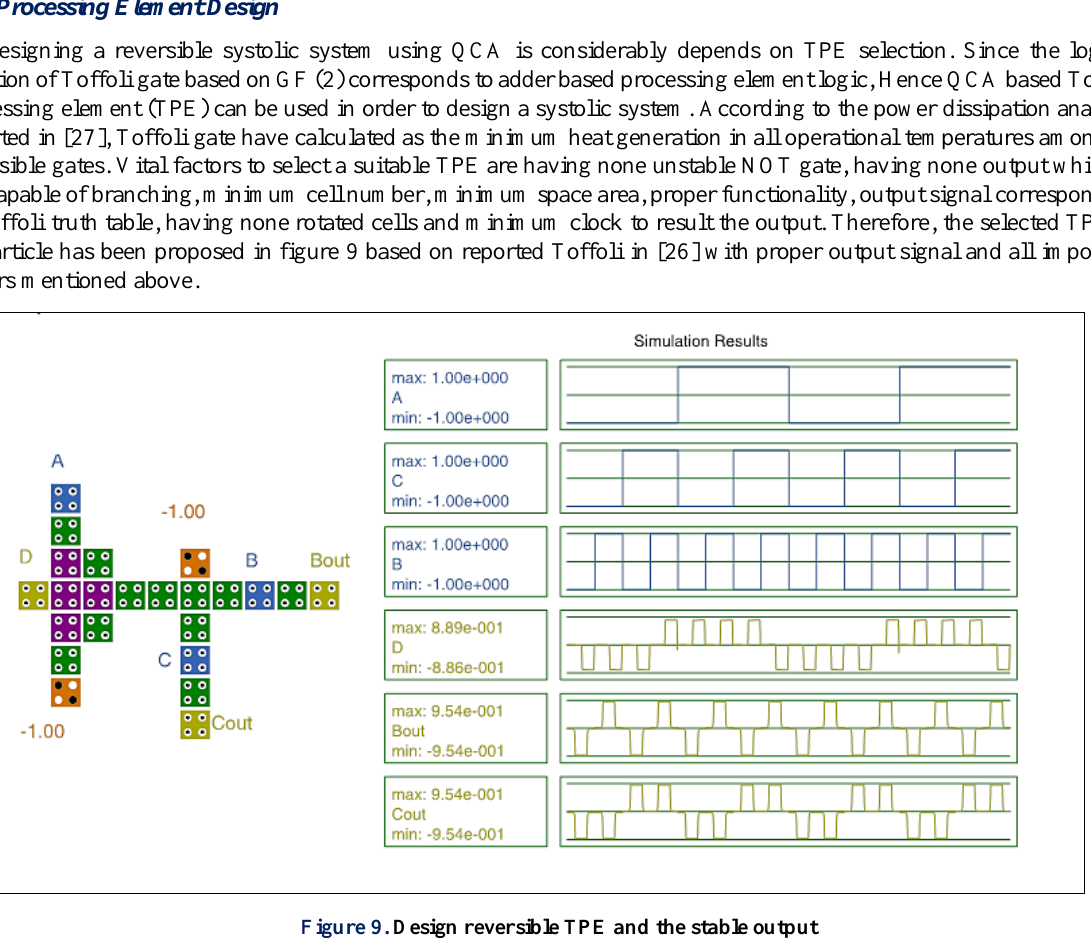
Figure 9. Design reversible TPE and the stable